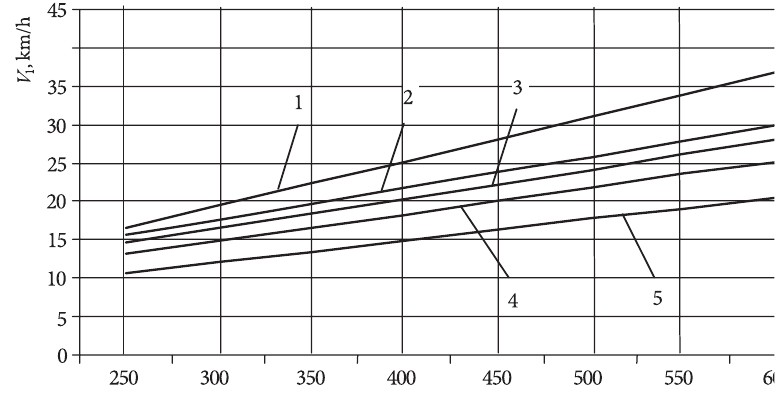
Fig. 9. Dependence of car speed before hit and car deformation aft er hit C and car stiff ness in case of non-central collision with a i tree, when coeffi cients of stiff ness are following: 1 – A = 65.5 kN/m, B = 500 kN/m 2 ; 2 – A = 63.8 kN/m, B = 400 kN/m 2 ; 3 – A = 95.2 kN/m, B = 760 kN/m 2 ; 4 – A = 74.5 kN/m, B = 480 kN/m 2 ; 5 – A = 63.9 kN/m, B = 358 kN/m 2